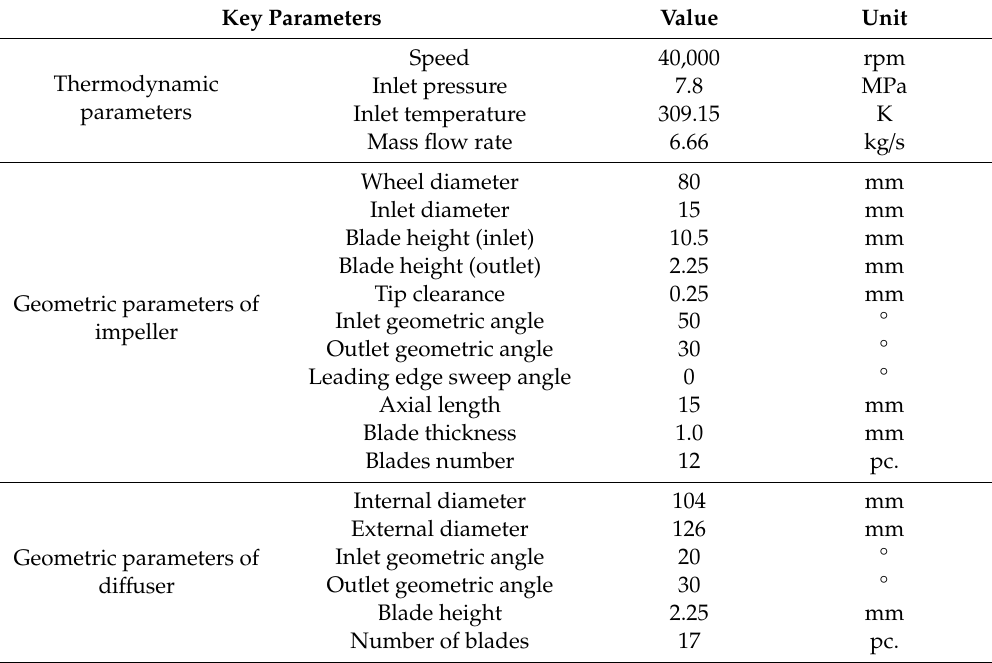
Table 3. Key parameters of the optimal design of the compressor.